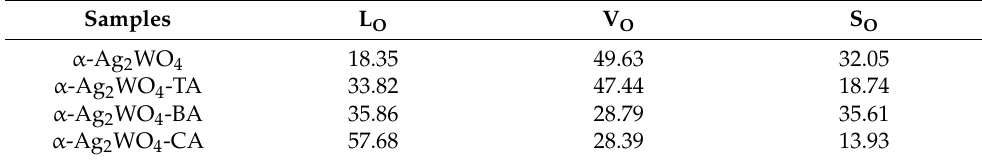
Table 1. Calculated percentage values of the amount of L O , V O , and S O (%) based on the deconvolu- tion of the O 1 s peaks as a function of BE.